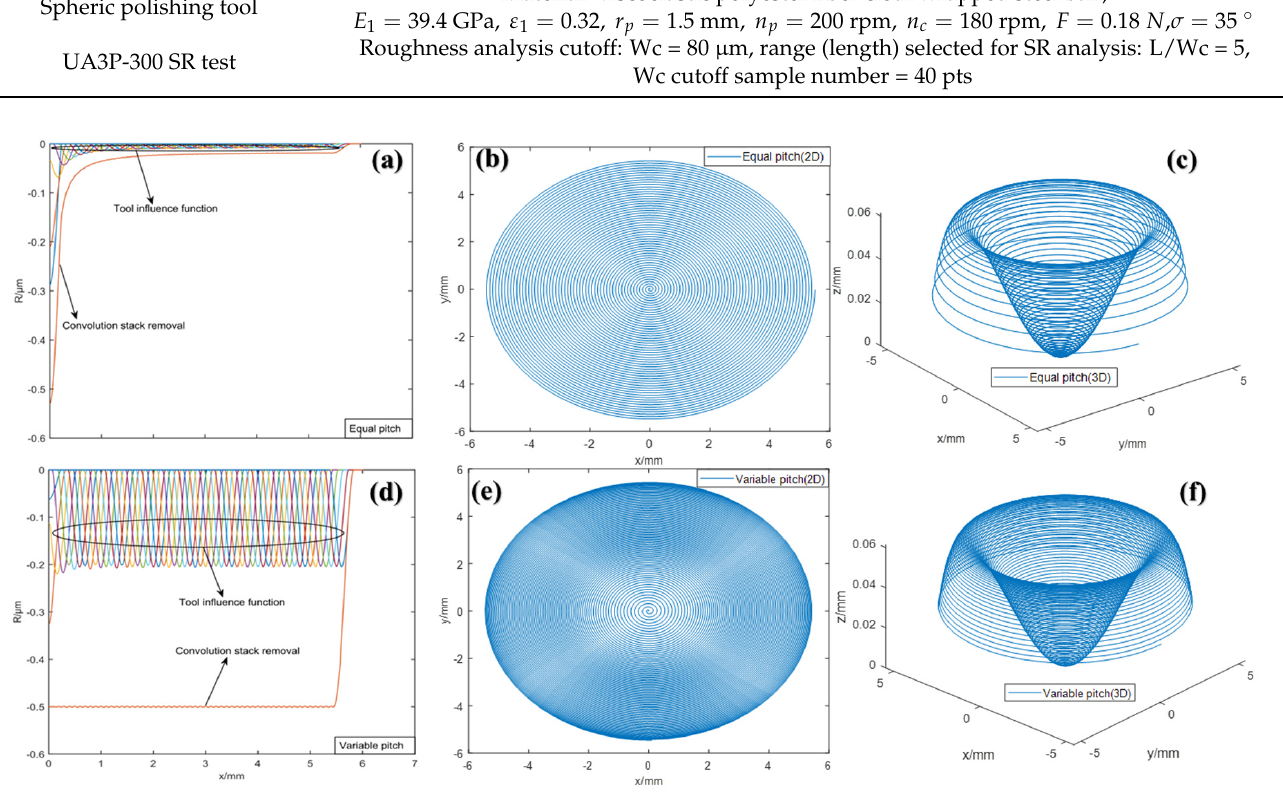
Structure: Semi-flexible microstructure of bonded diamond particles, bonded diamond